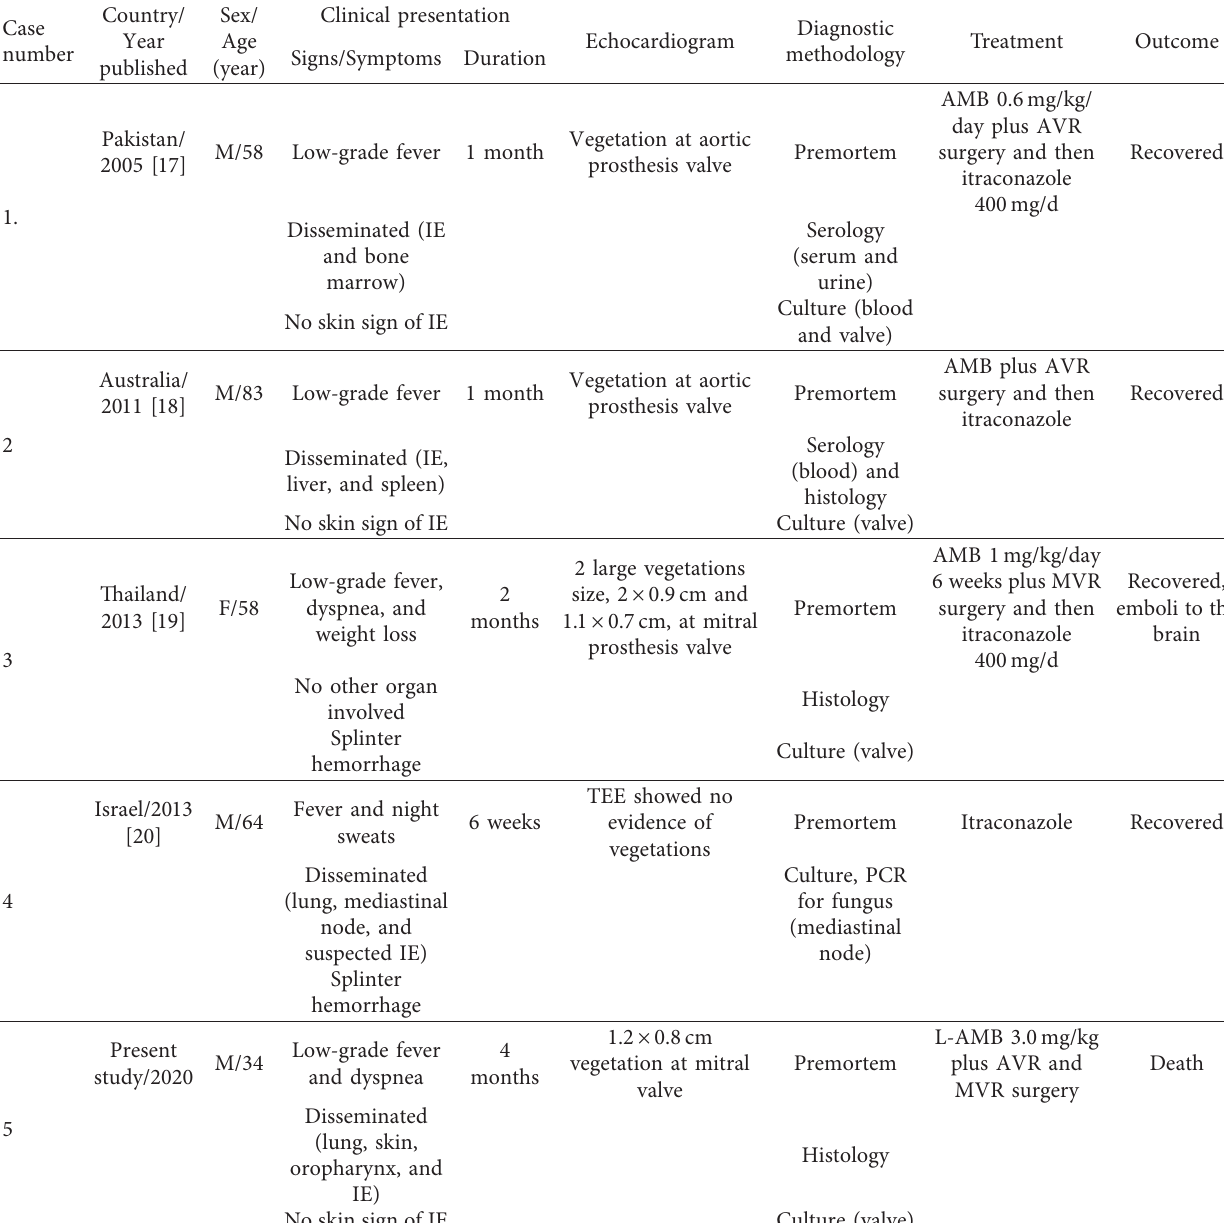
Table 1: A literature review of infective endocarditis caused by Histoplasma capsulatum in Asia and Australia.